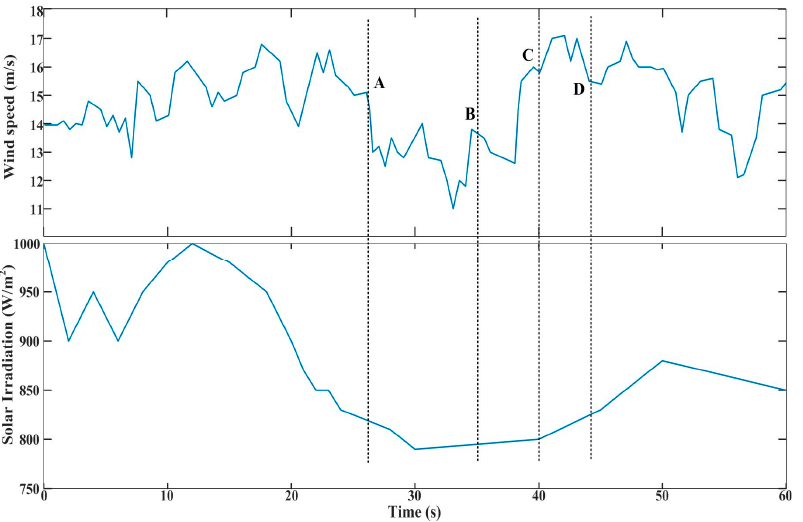
Figure 11. Profiles of wind speed and solar irradiation. Table 2. CCT of generator-2 when connected to different RES at different fault